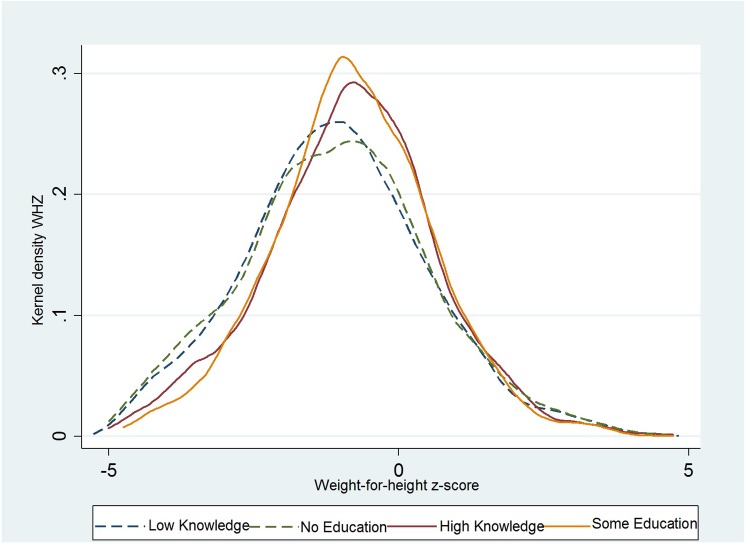
Kernel density plots of the distribution of child’s WHZ scores by mother’s knowledge and mother’s education.